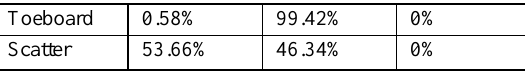
Table 1. Confusion matrix of synthetic point cloud result without noise.